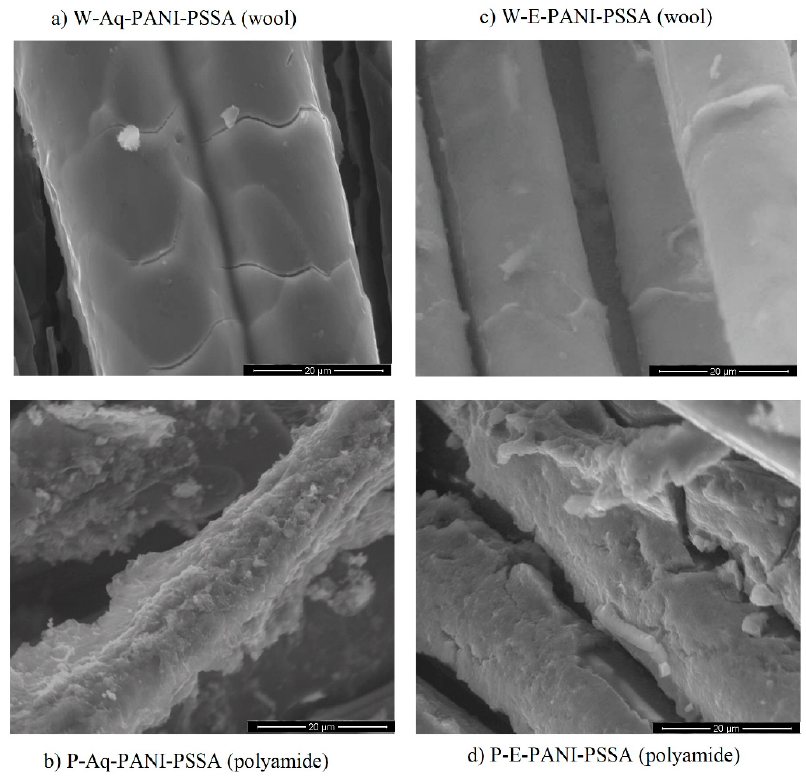
Figure 1. SEM images of coated textiles: ( a ) W-Aq-PANI-PSSA (wool); ( b ) P-Aq-PANI-PSSA (poly- amide); ( c ) W-E-PANI-PSSA (wool); ( d ) P-E-PANI-PSSA (polyamide).